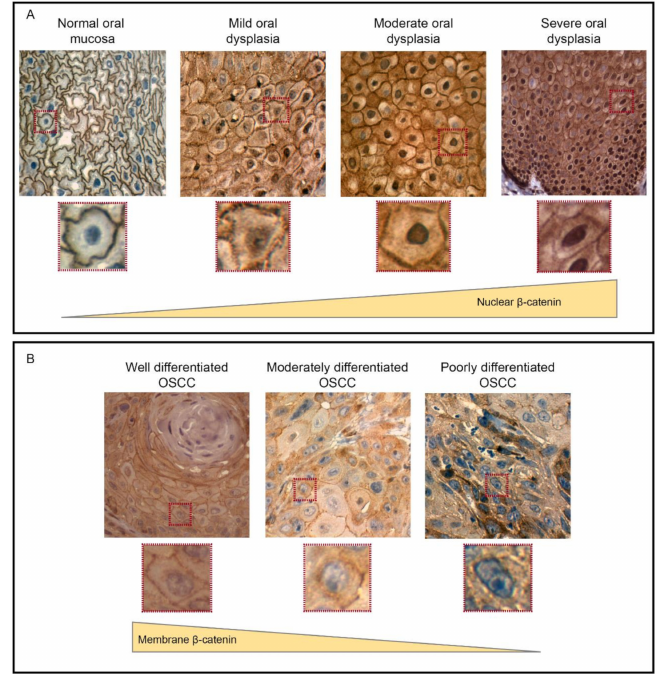
Figure 3. The expression and localization of β -catenin during oral carcinogenesis. ( A ) Immunohistochemistry of β -catenin in human oral samples, which revealed that β -catenin is mainly found at the plasma membrane of epithelial cells in normal oral mucosa samples. However, in oral dysplasia, β -catenin is mostly accumulated at the cytoplasm and nucleus of epithelial cells. Importantly, the nuclear detection of β -catenin is progressively increased according with the degree of dysplasia, with the strongest detection in severe and moderate oral dysplasia (zoomed images are shown in lower panels). ( B ) In OSCC, nuclear β -catenin levels are lower than oral dysplasia. On the other hand, plasma membrane-associated β -catenin decreases when shifting from well-di ff erentiated to moderate and poorly di ff erentiated OSCC (zoomed images are shown in the lower panels). This figure was modified with permission from “Increased nuclear β -catenin expression in oral potentially malignant lesions: A marker of epithelial dysplasia”, Reyes M. et al. 2015, Med Oral Patol Oral Cir